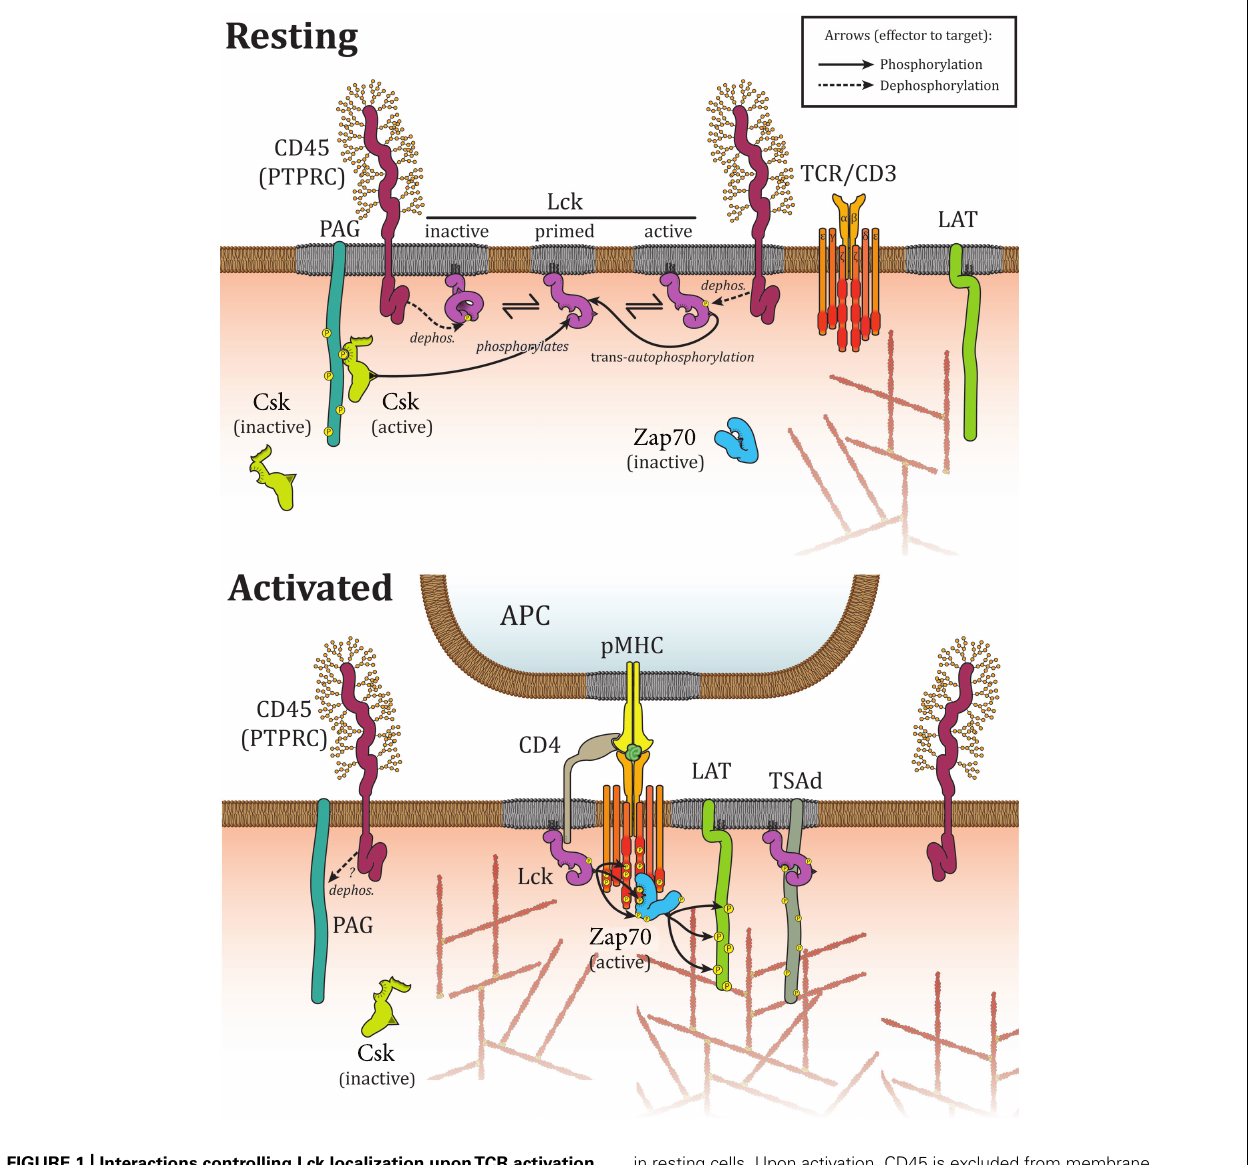
FIGURE 1 | Interactions controlling Lck localization uponTCR activation. In resting cells, Lck is located in microdomains where it interacts directly with CD45 that acts both on activatingTyr394 and inhibitingTyr505. Csk is targeted to membrane microdomains by PAG and aids to limit Lck activity via Tyr505 phosphorylation. Association with membrane domains and protein–protein interactions prevent constitutively active Lck to phosphorylateTCR or Zap70